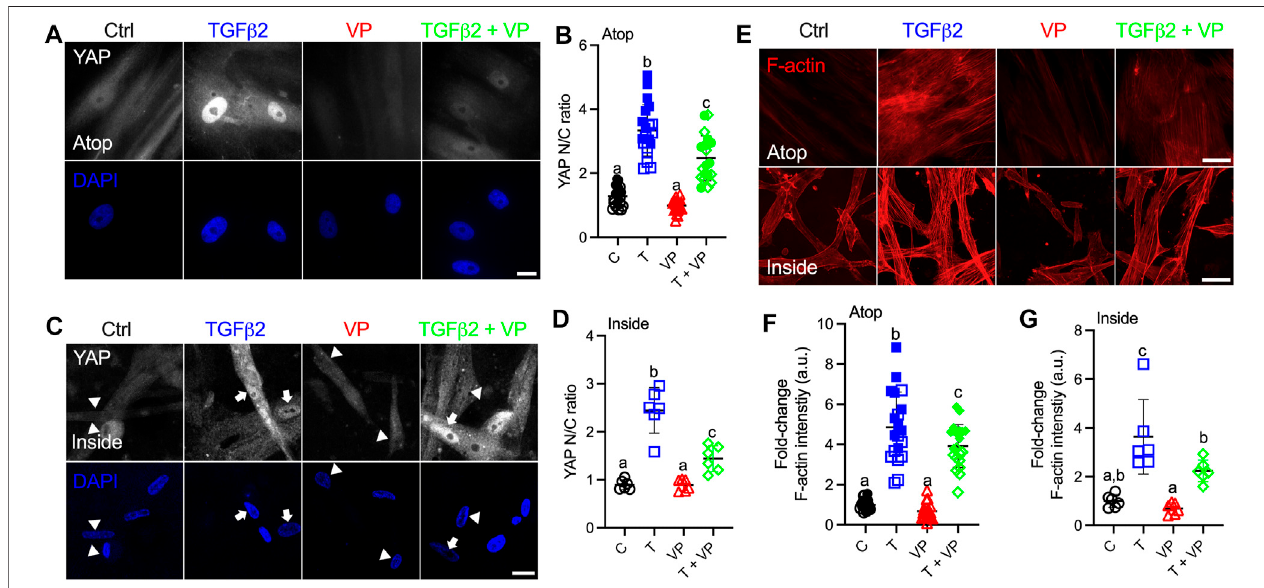
FIGURE6| InhibitionofYAP/TAZ-TEADinteractionwithVPdecreasesnuclearYAPandF-actinlevels. (A) Representative fl uorescencemicrographsofYAPinHTM cells cultured on top of soft hydrogels subjected to control, TGF β 2 (2.5 ng/ml), VP (0.5 µM), TGF β 2 + VP at 3 days (YAP = grey; DAPI = blue). Scale bar, 20 μ m. (B) Analysis of YAP nuclear/cytoplasmic ratio ( n = 20 images from 2 HTM cell strains with three replicates per cell strain). (C) Representative fl uorescence micrographs of YAP in HTM cells encapsulated in soft hydrogels subjected to the different treatments at 3 days (YAP = grey; DAPI = blue). Arrows indicate higher YAP in nuclei, arrowheads indicate higher YAP in cytoplasm. Scale bar, 20 μ m. (D) Analysis of YAP nuclear/cytoplasmic ratio ( n = 6 images from one HTM cell strain with three replicates). (E) Representative fl uorescence micrographs of F-actin in HTM cells on or inside of soft hydrogels subjected to the different treatments (F-actin = red). Scale bar, 50 μ m. (F) Analysis of F-actin intensity in HTM cells on soft hydrogels ( n = 20 images from 2 HTM cell strains with three replicates per cell strain). (G) Analysis of F-actin intensity in HTM cells inside of soft hydrogels ( n = 6 images from one HTM cell strain with three replicates). Open and closed symbols represent different cell strains. The lines and error bars indicate Mean ± SD; Signi fi cance was determined by one-way ANOVA using multiple comparisons tests [shared signi fi cance indicator letters represent non-signi fi cant difference ( p > 0.05), distinct letters represent signi fi cant difference ( p < 0.05)].